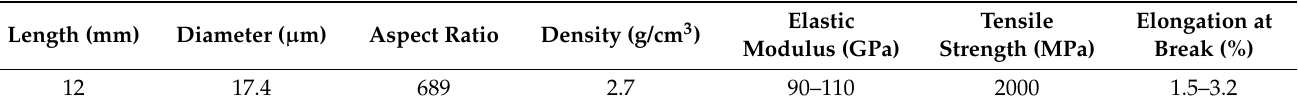
Figure 1. Gradation curve of fine aggregates used in the study.